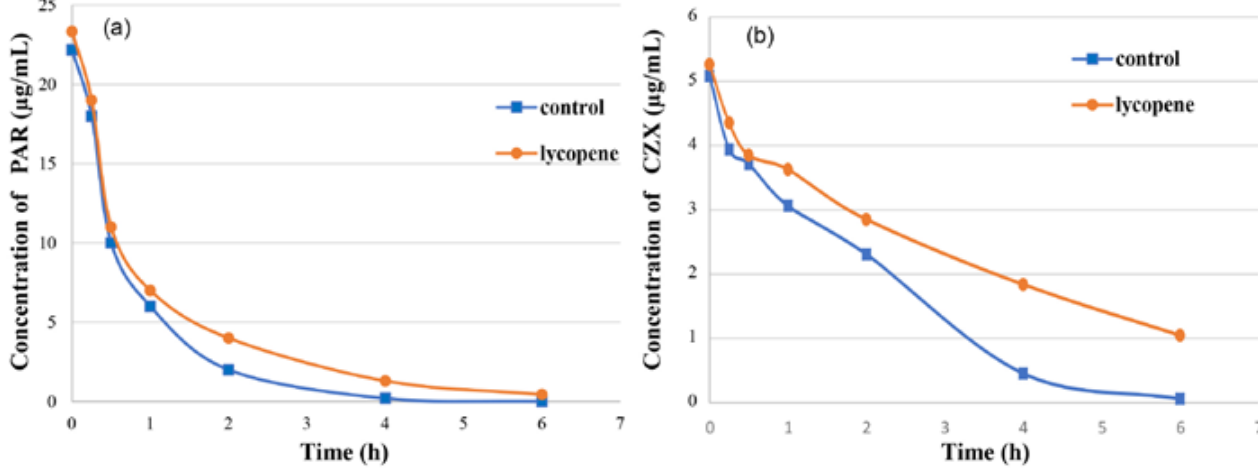
FIGURE 6 - (a) The concentration–time profile of paracetamol (25 mg/kg, IV) after treatment with water (control) or lycopene (20 mg/kg, ip) in rats (b) The concentration–time profile of chlorzoxazone (20 mg/kg, IV) after treatment with saline (control) or lycopene (20 mg/kg, ip) in rats.